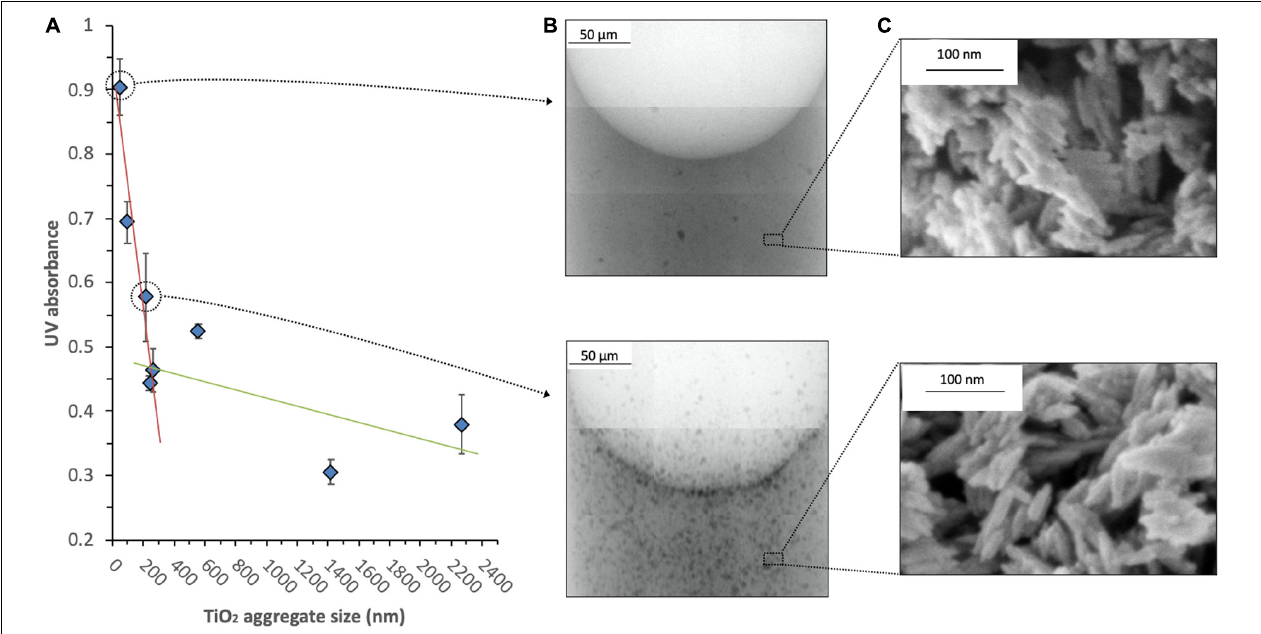
FIGURE 3 | Effect of TiO 2 nanoparticle aggregate size on the UV absorption efficacy. Different commercial nanoparticulate TiO 2 UV-filters were dispersed in a sunscreen oil phase. The UV absorption at the wavelength of 270 nm was measured by UV/vis spectrophotometer; it is plotted according to the aggregate size measured by dynamic light scattering (A) . The resulting homogeneity of the w/o sunscreen formulation was analyzed at the micrometric aggregate scale by 2D X-ray nano-tomography (B) . The top pictures show a finely dispersed UV-filter leading to homogeneous sunscreen and maximum UV absorption, while the bottom pictures correspond to an aggregated UV-filter leading to a heterogeneous sunscreen and lowered UV absorption (Catalano, 2020). However, both top and bottom UV-filters display similar primary nanoparticle structure at the nm scale, as observed by HR-scanning electron microscopy (C) .